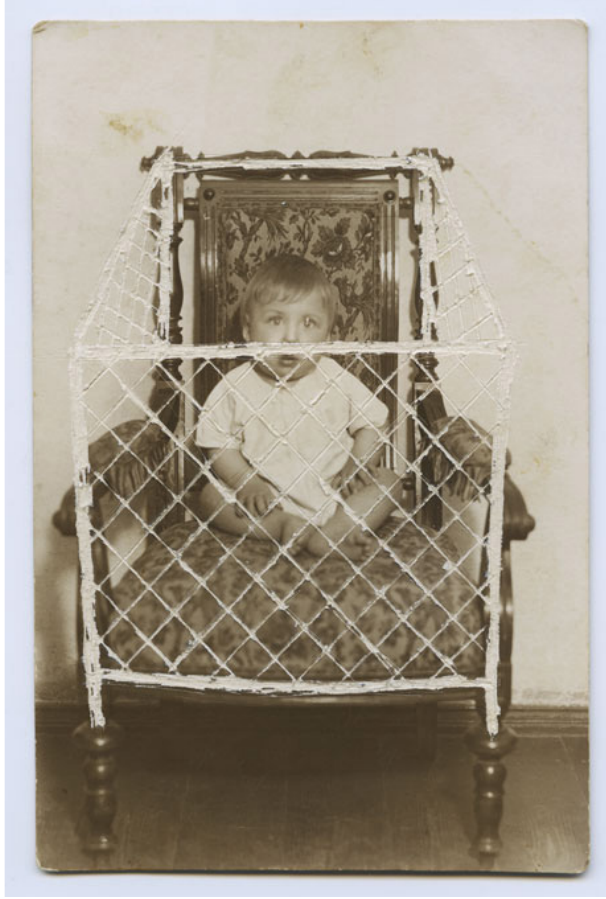
Figure 2. A child in the crib “My first photo. I’m 10 months old or so, I’m standing in my baby crib behind a safety net. Everything is blurred and barely visible, just like my memories.” ( Reconstruction of Memory | Curatorial Project by Lia Dostlieva and Andrii Dostliev ) Here the artist is trying to reinsert himself into his childhood memories by constructing a fake picture of himself. His forgetting of the past is, first and foremost, an act of forgetting himself in the past. There are very few pictures of the artist’s childhood and of himself. Every version is different, even the little boys (who now play the role of him as a child) are placed in different situations. They are not proportional; they even have different faces—it is not the same child. But this does not matter. The author does not care how they look, who they really are or how they are dressed. His task is to give them as many details as he can remember. Adding new elements creates a different scenario of the little boy’s life, making the artist’s own identity rhizomatic, nomadic—available in different